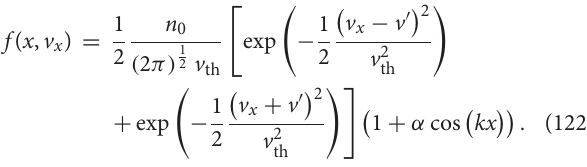
0.5634 and 0.1742 are −